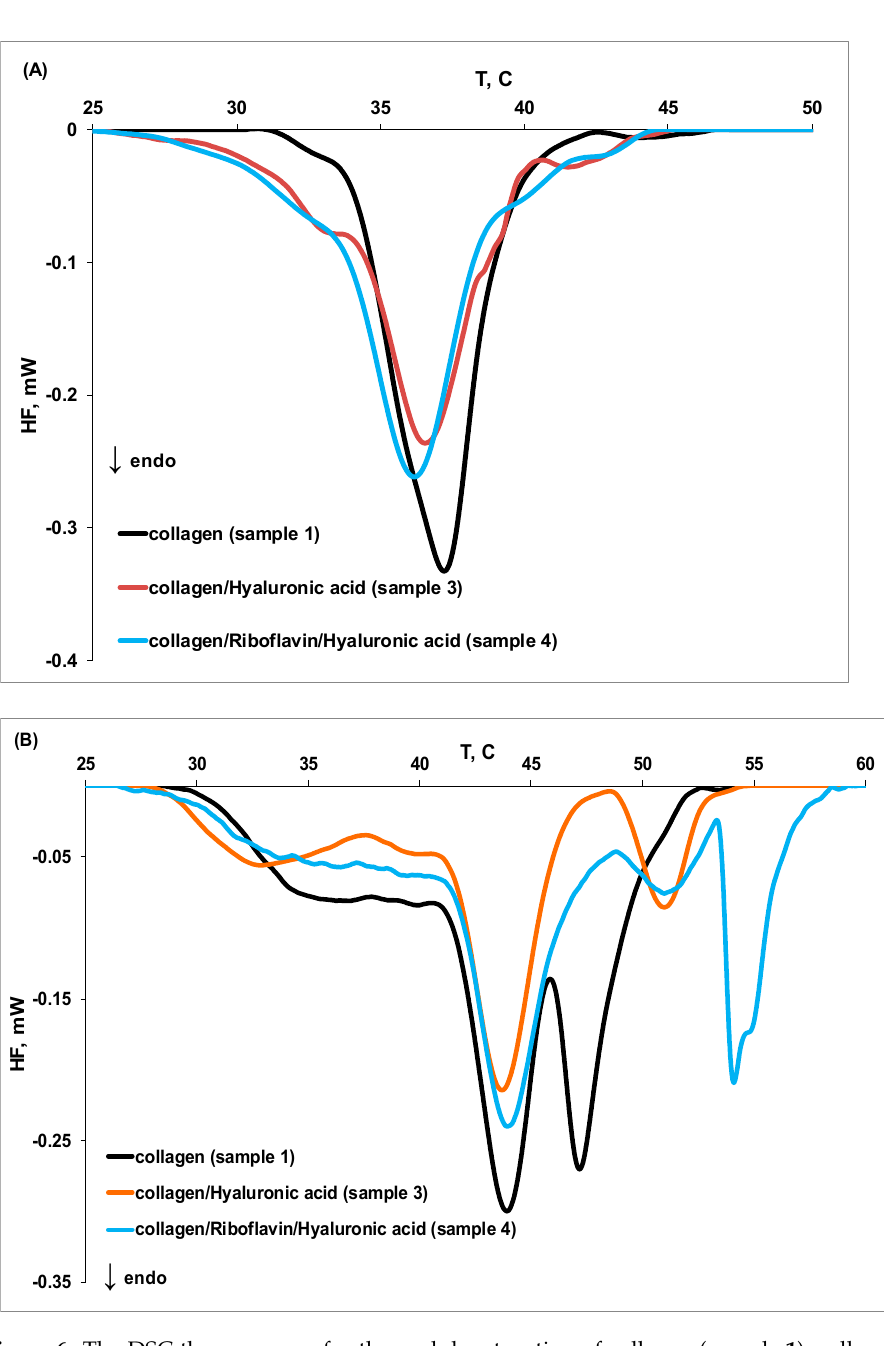
Figure 6. The DSC thermograms for thermal denaturation of collagen (sample 1 ), collagen in the presence of hyaluronic acid (sample 3 ), and collagen in the presence of hyaluronic acid and riboflavin (sample 4 ) at ( A ) pH 3.5 and ( B ) pH 7.5.